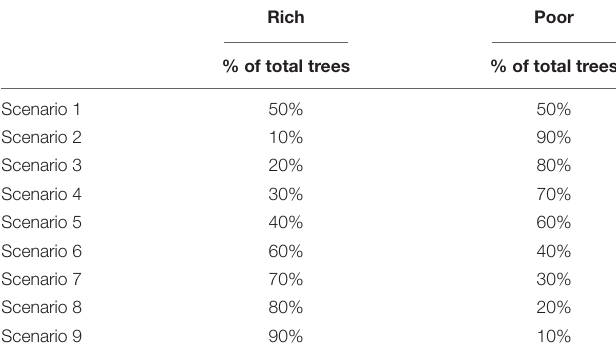
TABLE 2 | Distributional rule for scenarios.